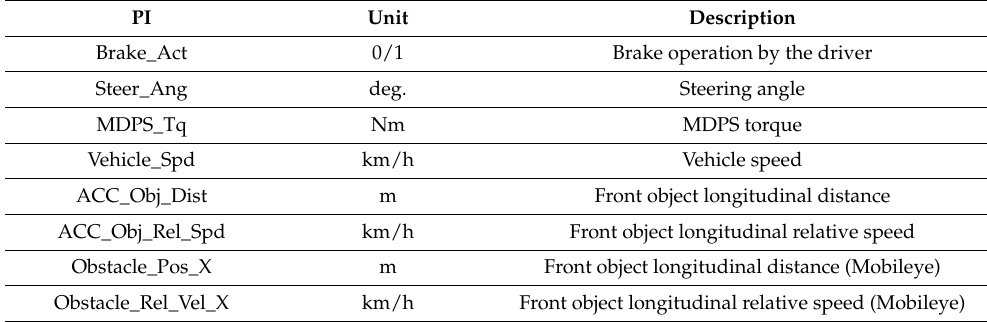
Table 12. Parts of PIs for safety assessment of the pilot